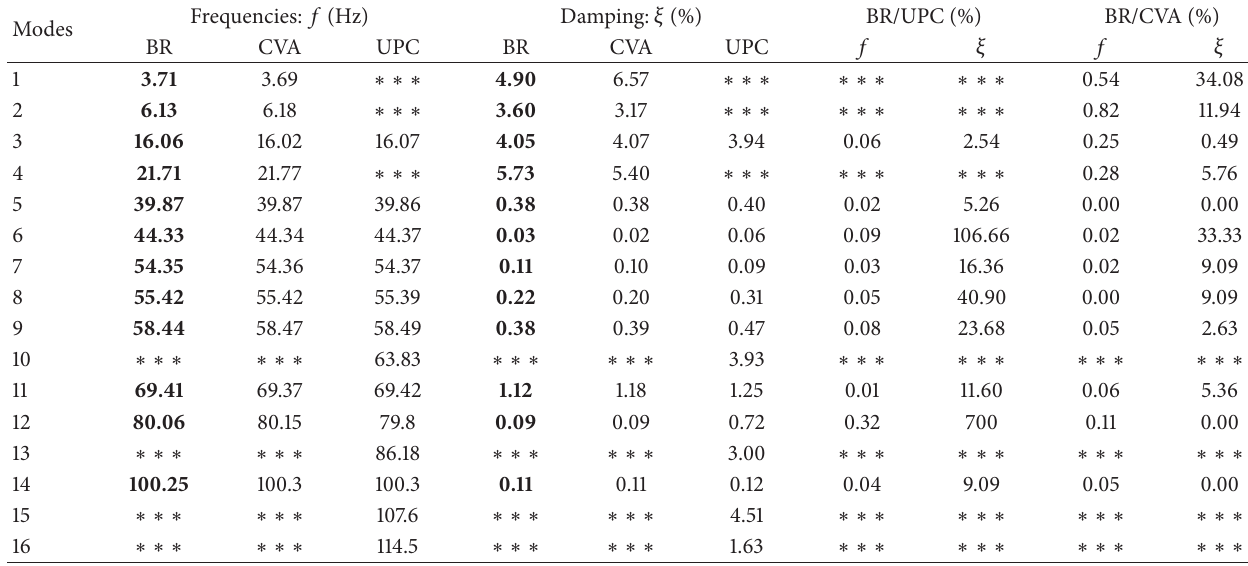
Table 1: The identified frequencies and damping using several algorithms. Modes